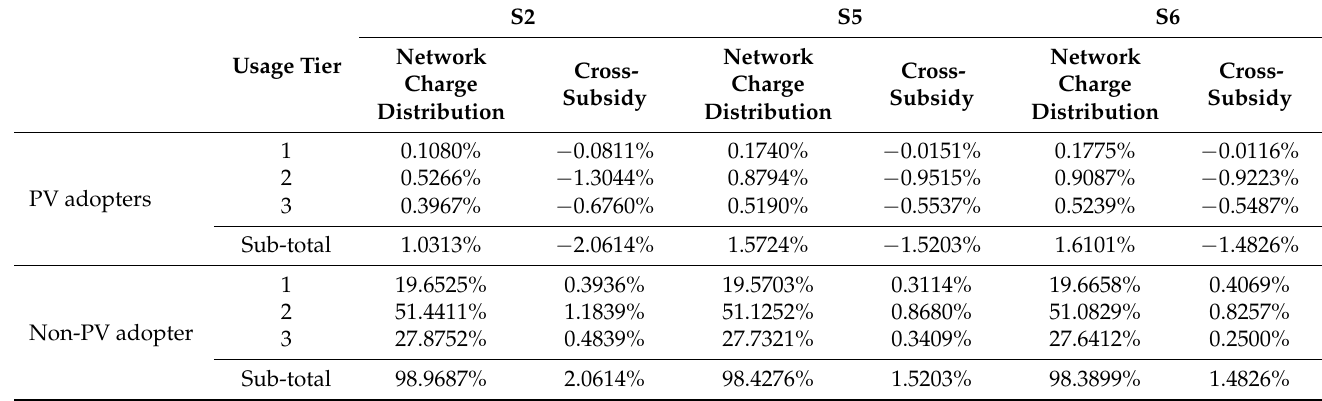
Table 7. Network charge distribution and cross-subsidies by usage tiers under the new network charge designed to recover 100% of network costs plus network charge adjustments through energy charge (scenario 5) and through capacity charge (scenario